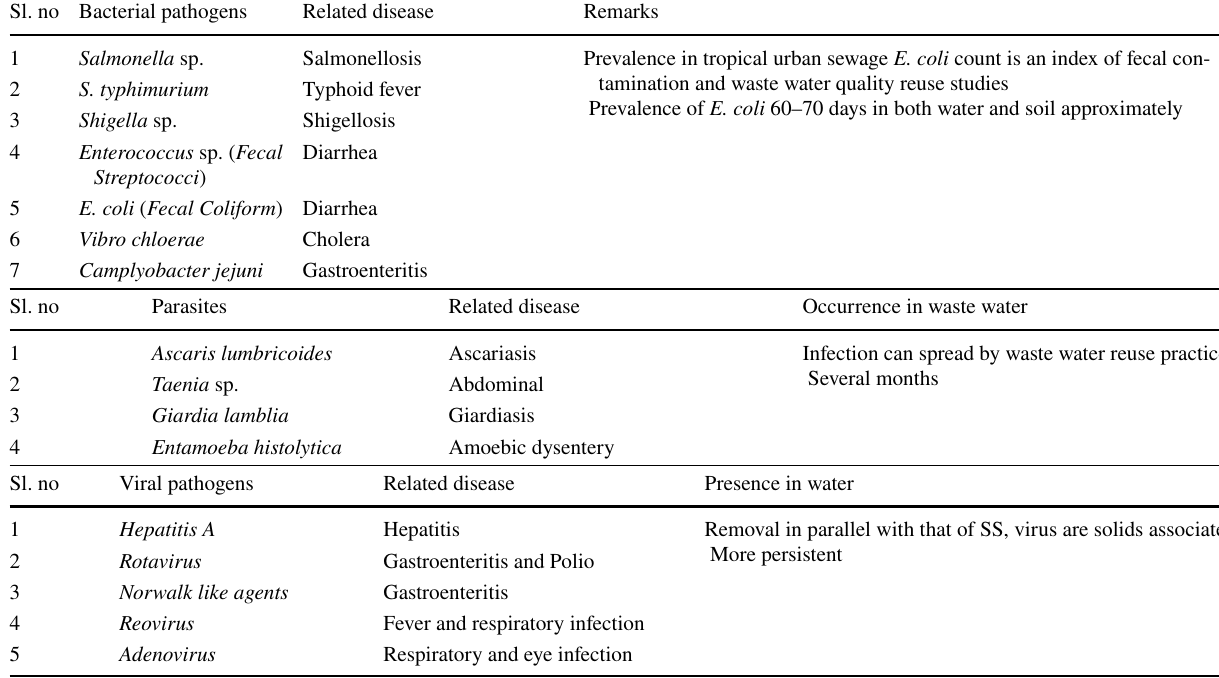
Table 1 Sewage microflora and their associated diseases. Source: Mara and Cairncross (1989); Pescod (1992), Pereira et al. (2002) and El- Motaium